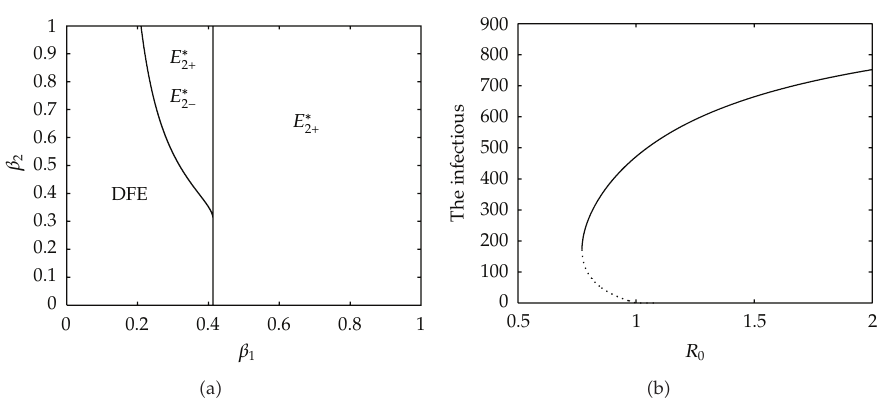
Figure 2: The backward bifurcation of model (cid:2) 3.9 (cid:3) : (cid:2) a (cid:3) The domain with di ff erent number of endemic equilibria in β 1 β 2 -plane, (cid:2) b (cid:3) The bifurcation curve of model (cid:2) 3.9 (cid:3)